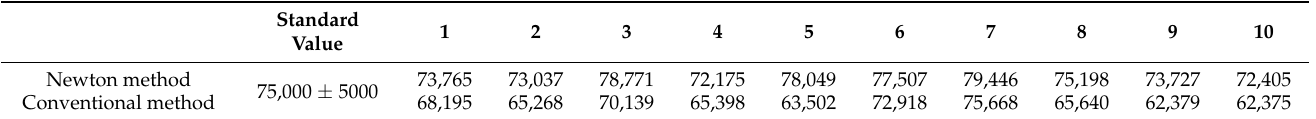
Table 1. Comparison of The Compression Energy Coefficient C between the Newton Method and the Conventional Method.